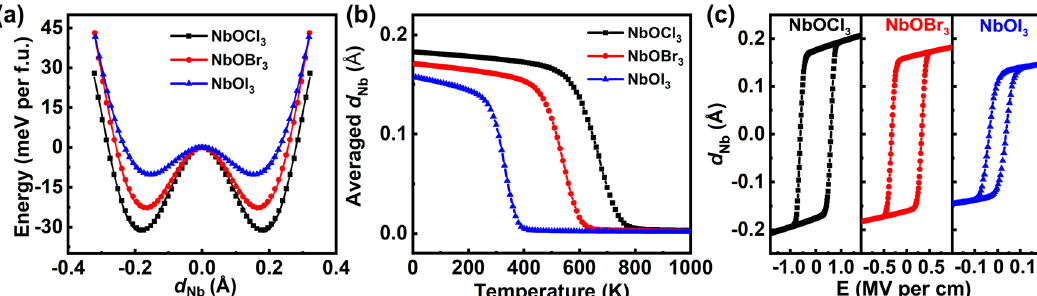
Fig. 4 Double-well potential and MC simulation results. a Energy- d Nb double-well plots connecting the PE and the two degenerate FE phases (- P and P states) in 1D NbOX 3 . The DFT data is fi tted using the Landau-Ginzburg model. b The averaged Nb polar displacements of 1D FE NbOX 3 as a function of temperature as obtained from MC simulations. c The ferroelectric hysteresis loops of 1D FE NbOX 3 simulated by MC calculations at room